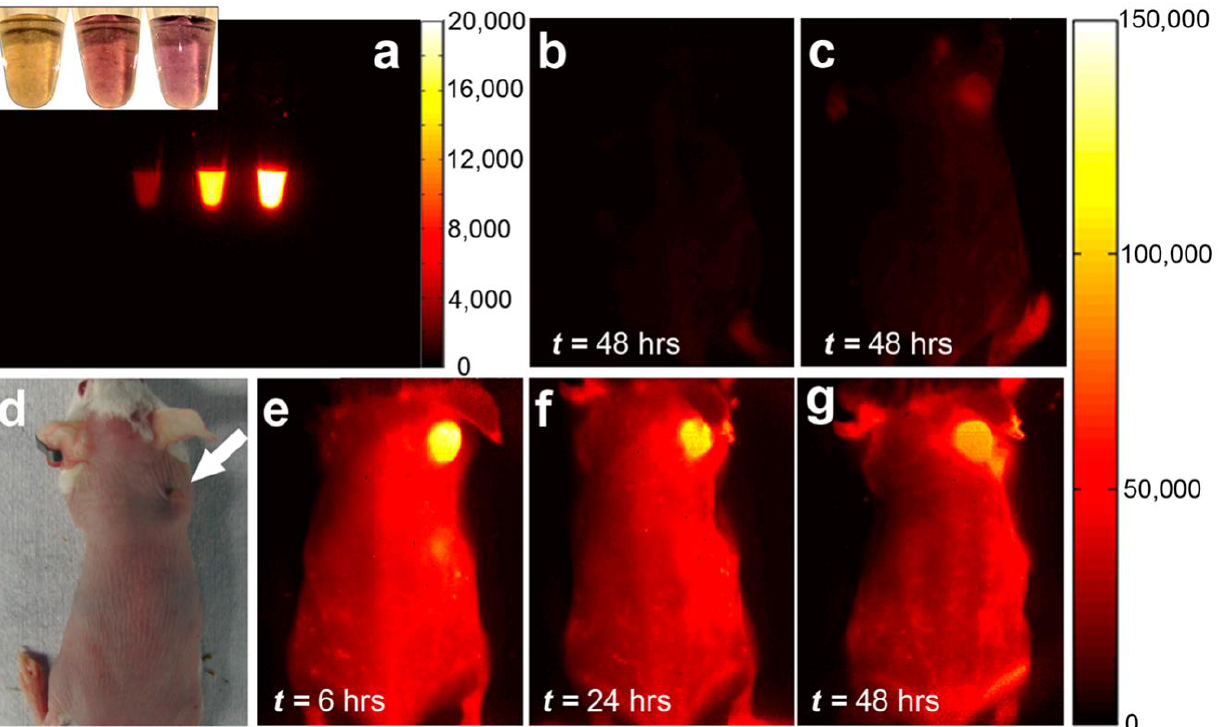
Figure 22. Time course fluorescence imaging and NIR (6,5) photoluminescence in the NIR-II. ( a ) An optical and NIR PL image of 50 L of C18-PMH-mPEG dispersed as synthesized HiPCO, first iteration (6,5) and second iteration (6,5), taken in the order of left to right and at a concentration of 22.2 g/mL. ( b , c ) NIR-II fluorescence pictures of a mouse injected with PBS and HiPCO and carrying a 4T1 tumor. ( d ) A mouse with a 4T1 tumor on its right shoulder is depicted optically. ( e – g ) From left to right, NIR-II fluorescent time series imaging demonstrates distinct SWCNT accumulation in the 4T1 tumor at 12, 24, and 48 h after injection. All animals received an injection of 0.254 mg/kg of SWCNTs, and after stimulation at 808 nm with a laser power density of 0.14 W/cm 2 , emission was measured from 0.9 to 1.4 m. Each NIR image of the 4T1 tumor-bearing Balb/c mice is scaled to the right [141]. Copyright 2013, American Chemical Society.